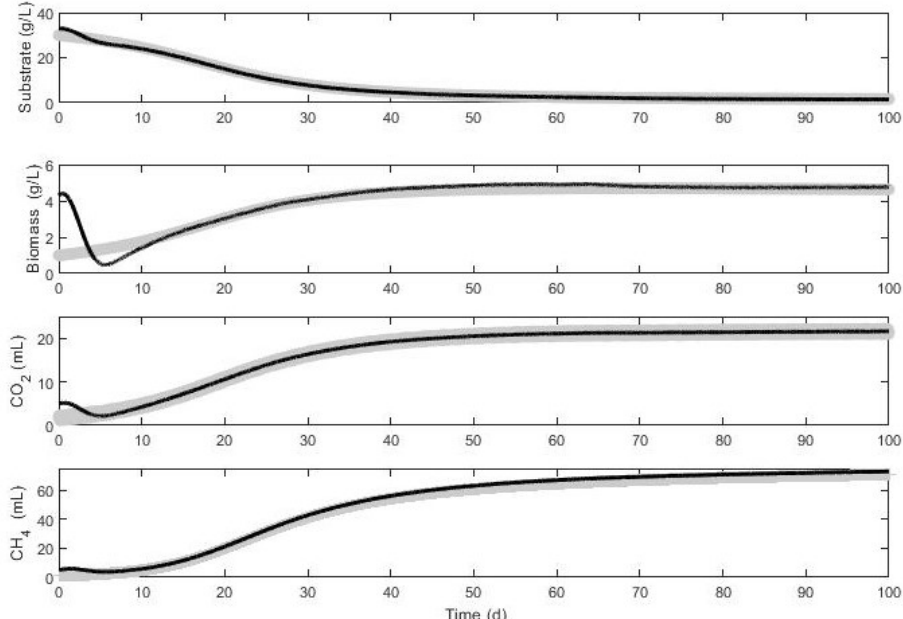
Figure 10. Simulation of disturbances considering noise in the CO 2